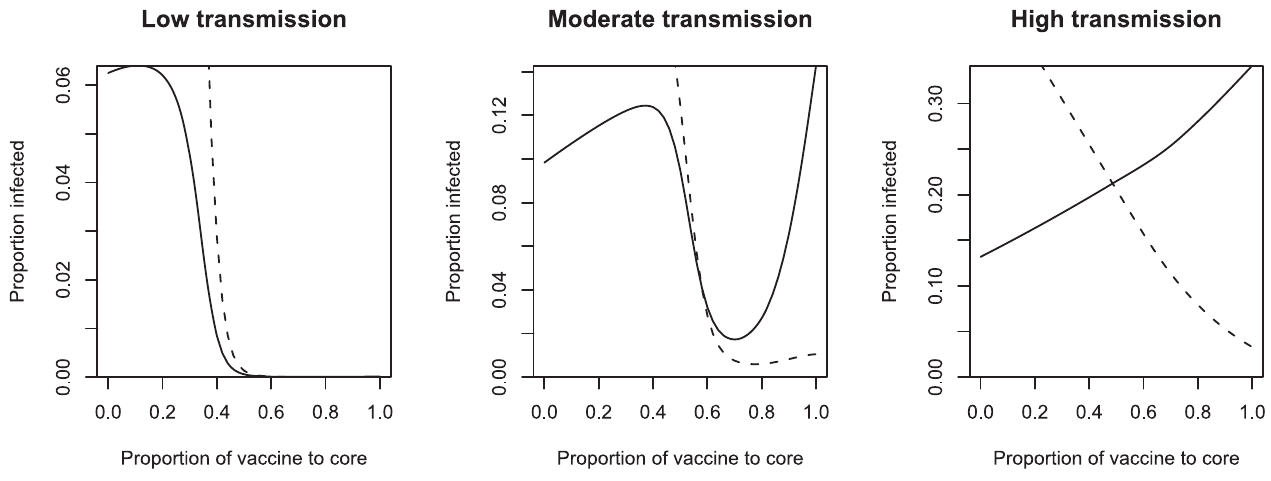
Figure 1. Complex Tradeoffs in Vaccine Allocation in a Population with Strong Assortative Mixing The proportion of ‘‘ vulnerable ’’ (solid lines), and ‘‘ core ’’ (dashed lines) individuals infected as a function of the proportion of vaccine given to core individuals, for three different transmission scenarios. In low transmission, the value of R for core and vulnerable individuals is 2.0 and 1.2, respectively; in medium transmission R is 2.4 and 1.6; in high transmission R is 2.8 and 2.0. The overall proportion of the population vaccinated is 0.5. The vaccine is assumed to have an efficacy of 80% in protecting core individuals and 50% in protecting vulnerable individuals. The two subpopulations are assumed to be of equal size. The coefficient of preferred mixing used is 0.7 (see Methods).